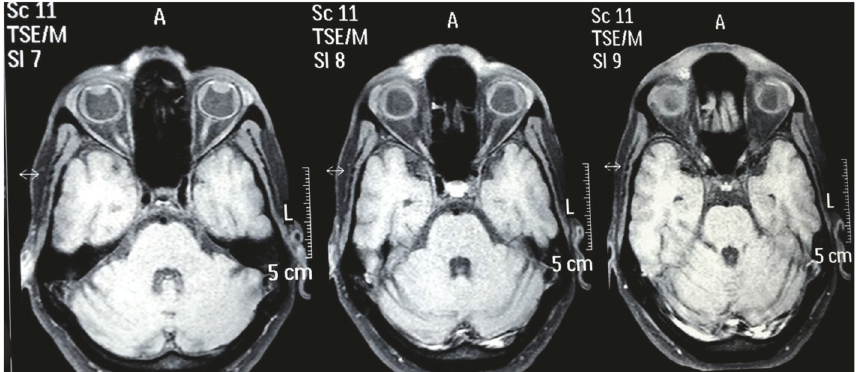
Figure 3: Axial T1 weighted MRI of head and orbit showing bilateral choroidal detachment with bilateral suprachoroidal